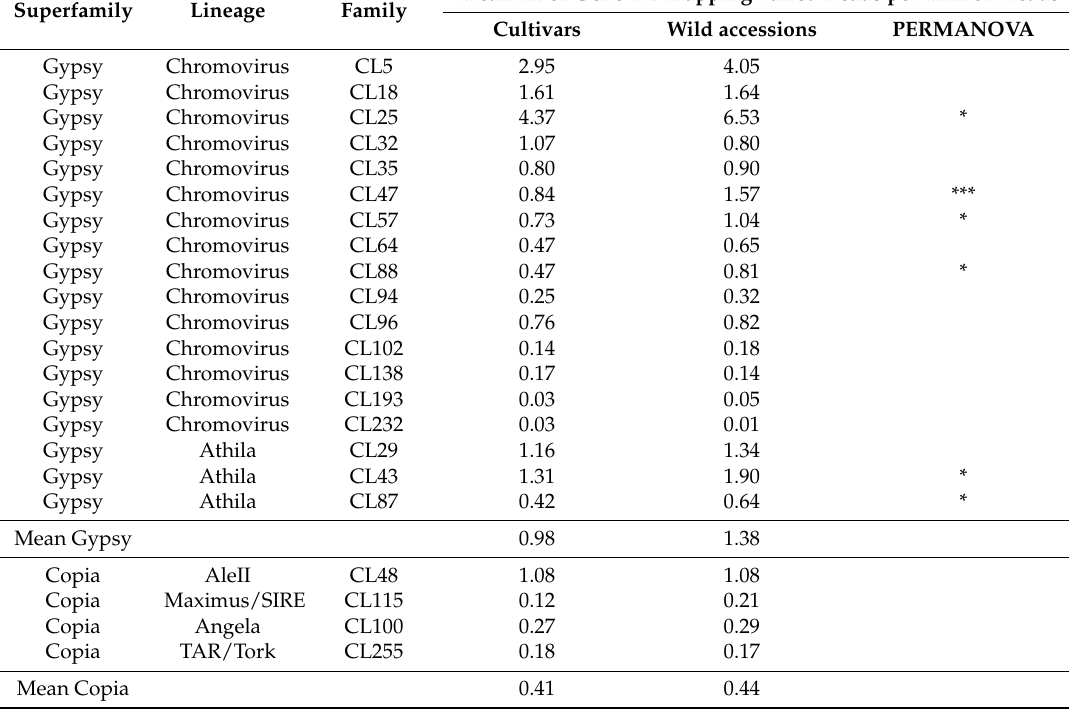
Table 2. Mean number (per million reads) of paired reads where one read maps to a LTR-RE family and the other to a gene sequence. For each family, the lineage and the superfamily are reported. Statistical significance of differences between cultivars and wild accessions was assessed by PERMANOVA (*** p < 0.001; * p <